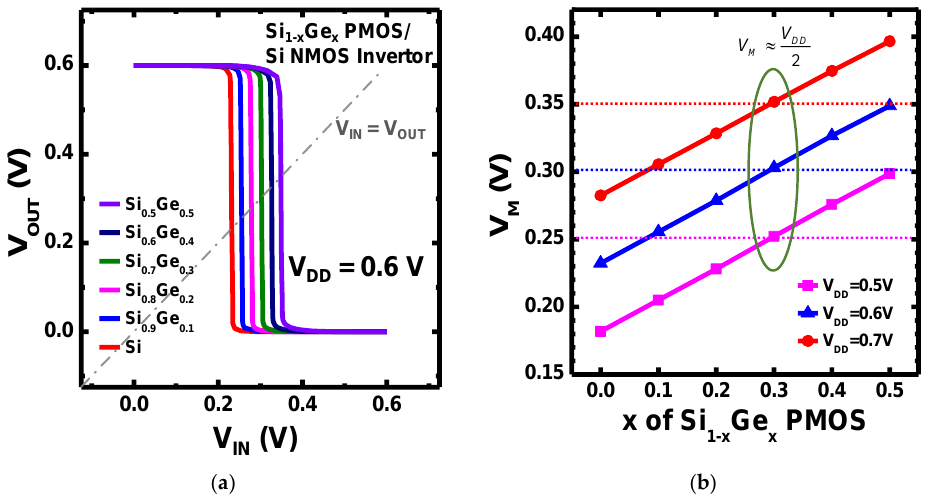
Figure 9. ( a ) The voltage transfer curves (VTC) of CFET inverter with Si 1-x Ge x PMOS and Si NFET. ( b ) The inverters’ switching thresholds (V M ) versus x in Si 1-x Ge x PMOS with V DD = 0.5, 0.6, and 0.7 V, and the dotted lines represent where the V M equals V DD /2.